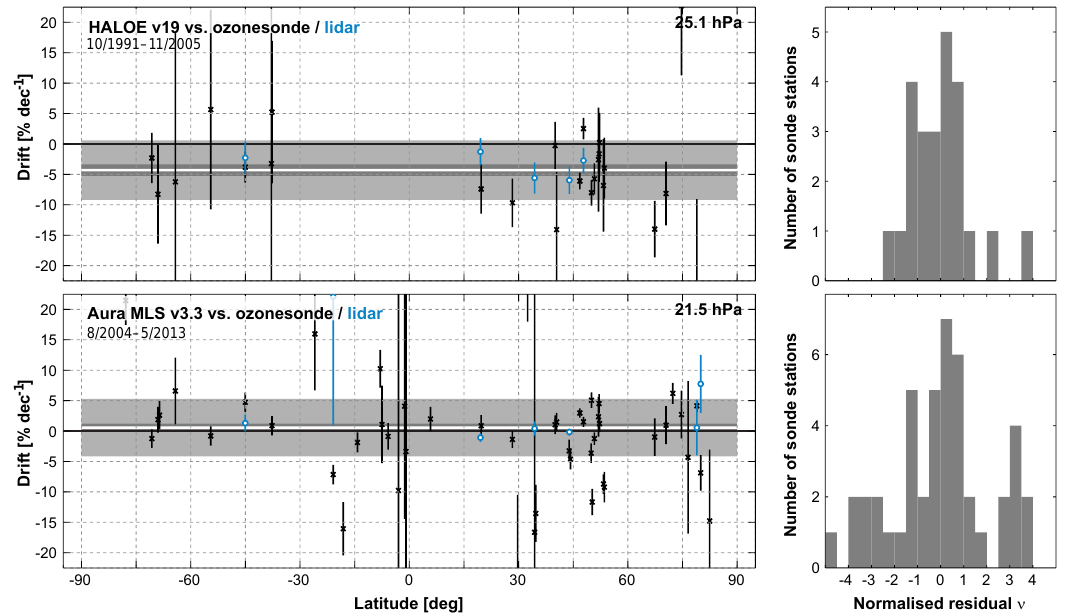
Figure 3. (Left) Drift ˆ α j and one sigma uncertainty ˆ σ α,j of HALOE (top) and Aura MLS (bottom) around 25km relative to co-located observations at each station in the NDACC/GAW/SHADOZ ozonesonde (black) and NDACC lidar (blue) networks. Also shown are the weighted mean for the ozonesonde network ¯ α (horizontal white line), its adjusted uncertainty σ ∗ ¯ of the ensemble of single sonde site drift estimates (light grey area). (Right) Corresponding distribution of normalised residuals ν from the ozonesonde